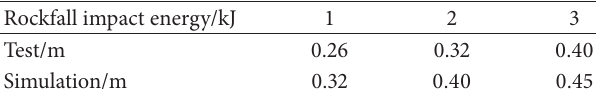
Table 4: The contrast of the maximal compressed